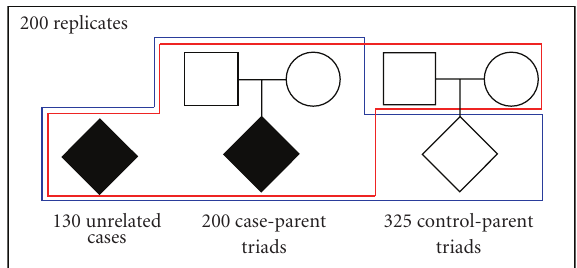
Figure 1: Cohort data used for simulations. 200 replicate datasets were generated for each model. For all of our calculations we used the same overall number of a ff ected individuals and case-parents however the methods di ff ered in how the case and control data were utilized in each individual test (see Materials and Methods). The same number of a ff ected individuals ( n = 330) and case-parents ( n = 400) was used under all three methods. For the combined case-control and conditional logistic regression analysis (CC+CLR) and the log-linear analysis using unrelated controls rather than their parents (HD-NPC), we used the genotypes of unrelated controls ( n = 325, in blue), whereas for the hybrid design using parents of controls in a log-linear framework (HD), we incorporated the genotypic information of the parents of these controls rather than the controls themselves ( n = 650, in